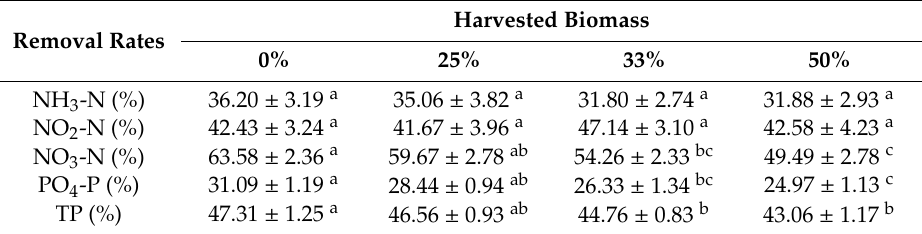
Table 2. Overall mean nutrient removal e ffi ciency for each treatment during the 58 day